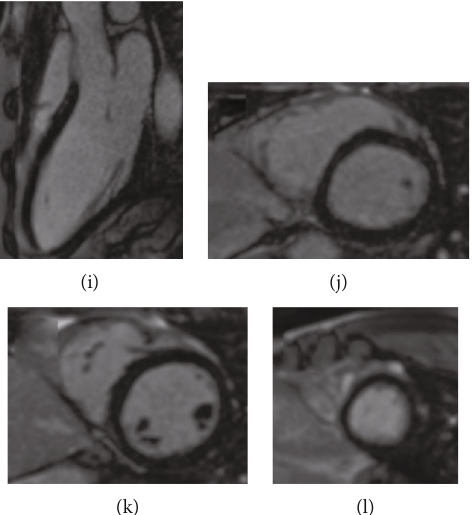
Figure 1: (a) resting ECG on admission showing early repolarization in V1-V3. (b – l) Nonperfusion cardiovascular magnetic resonance. (b – d) Cine steady-state free precession images. (e, f) T1 mapping by MOLLI 5s (3s) 3s showing normal native myocardial T1 at 1.5T (normal reference range at our center 950-1060ms). (g – l) Late gadolinium enhancement images with motion correction showing no focal myocardial fi